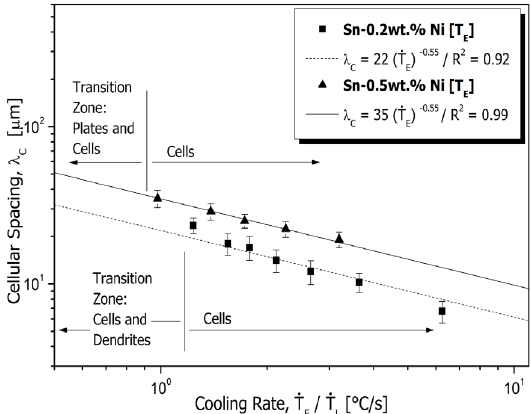
Figure 7. Experimental growth correlations expressing the variation of cellular spacing with the eutectic cooling rate for the Sn-Ni alloys. R 2 is the coefficient of determination